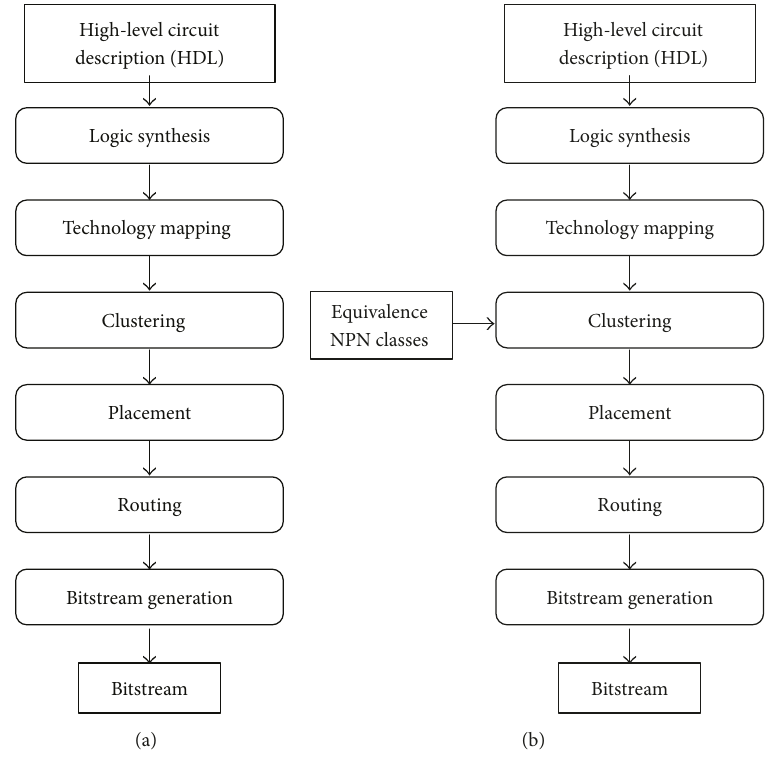
Figure 3: Modified CAD flow with equivalence analysis.